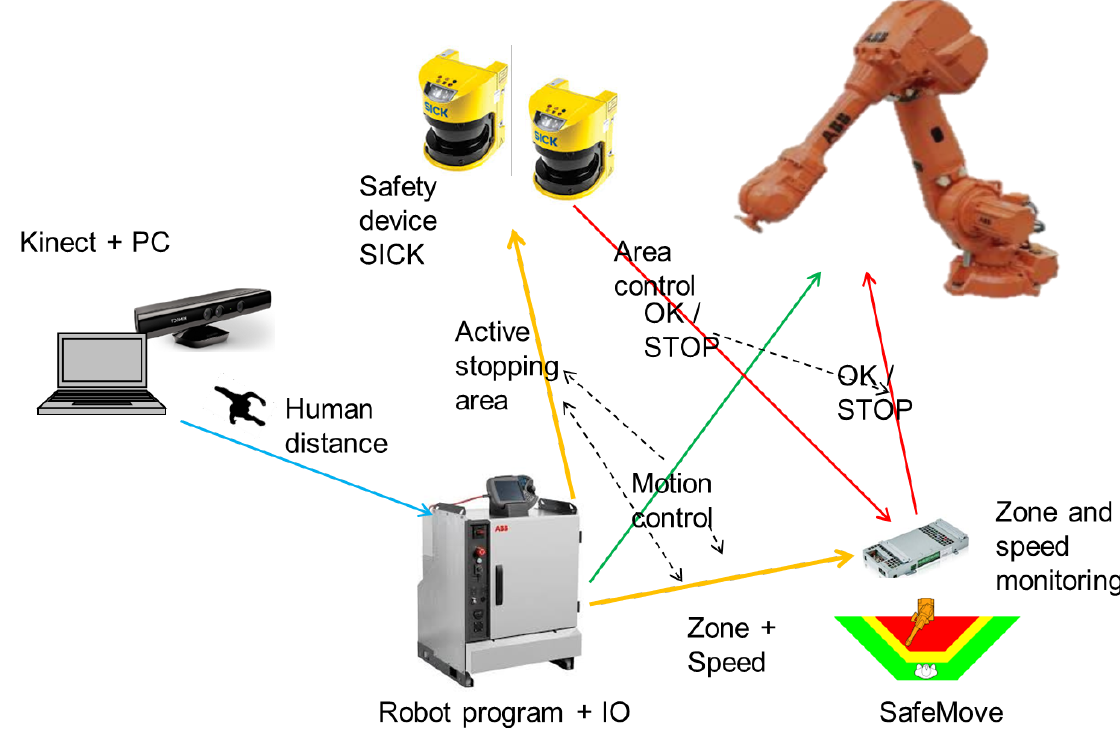
Figure 2: Devices used at the dynamic safety system